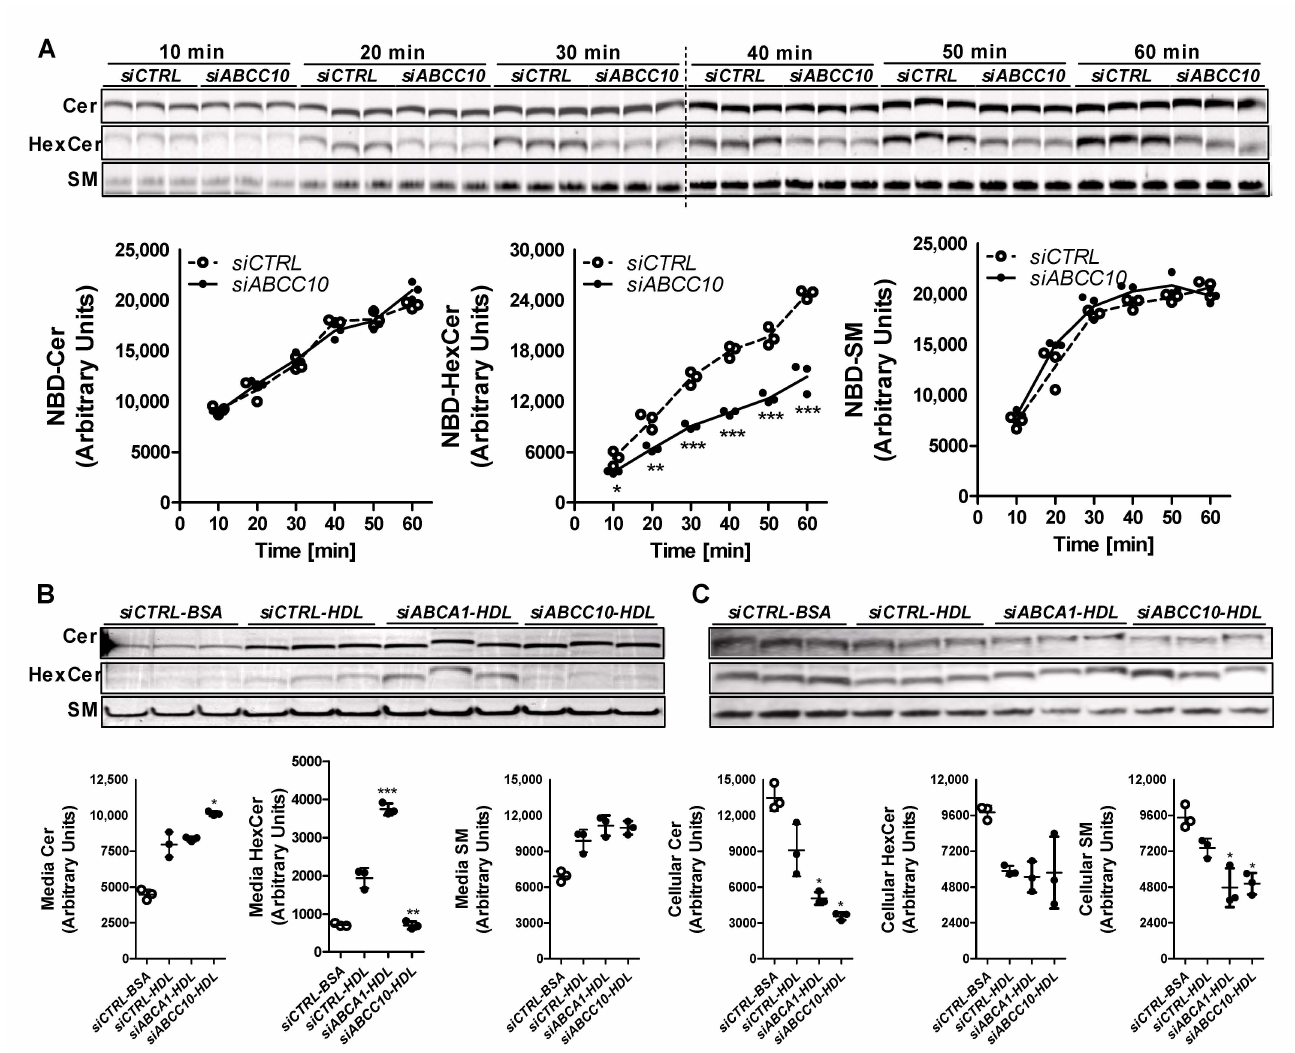
Figure 4. Role of ABCC10 in HexCer synthesis. ( A ) Synthesis of HexCer is decreased after treatment with siABCC10 . Huh-7 cells were transfected ( n = 3) with 50 nM siCTRL or siABCC10. After 72 h, cells were labeled with 2 µ M C6-NBD Cer for indicated time points and were washed thrice with 0.1% BSA containing DMEM. Cellular lipids were extracted, separated on TLC plates, fluorescence in Cer, SM, and HexCer bands were scanned using the PhosphorImager ( top ), and quantified by Image J ( bottom ). Values are plotted as replicates (Mean ± SD), * p < 0.05, ** p < 0.01 and *** p < 0.001 compared to siCTRL treated cells. ( B , C ) ABCC10 knockdown diminishes synthesis of [ 14 C]-HexCer and its transport to HDL. Huh-7 cells were transfected ( n = 3) with 50 nM siCTRL , siABCA1 or siABCC10. After 72 h, cells were labeled with 0.2 µ Ci of [ 14 C]-Cer in DMEM and used for efflux studies. Media ( B ) and cell ( C ) lipids were separated using TLC and radioactive Cer, SM, and HexCer bands were visualized with the PhosphorImager ( top ) and quantified using Image J ( bottom ). Values are replicates (Mean ± SD). * p < 0.05, ** p < 0.01 and *** p < 0.001 compared to siCTRL-HDL